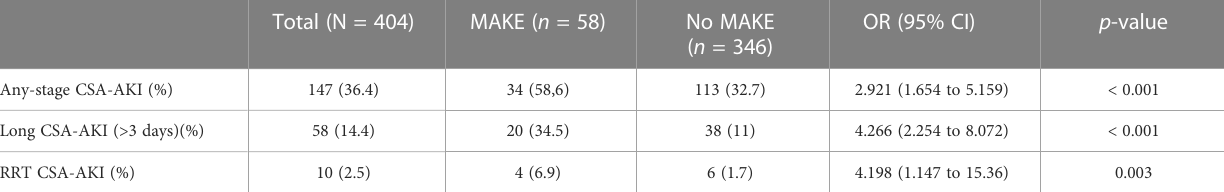
TABLE 3 Univariate analysis of CSA-AKI as a risk factor for 1-year